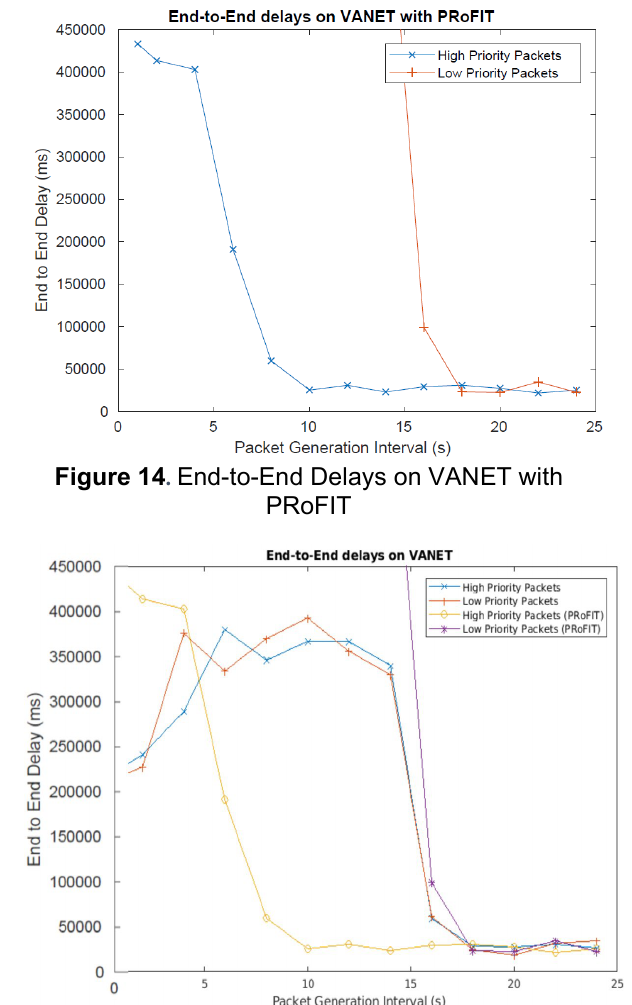
Figure 15 . End-to-End Delays on